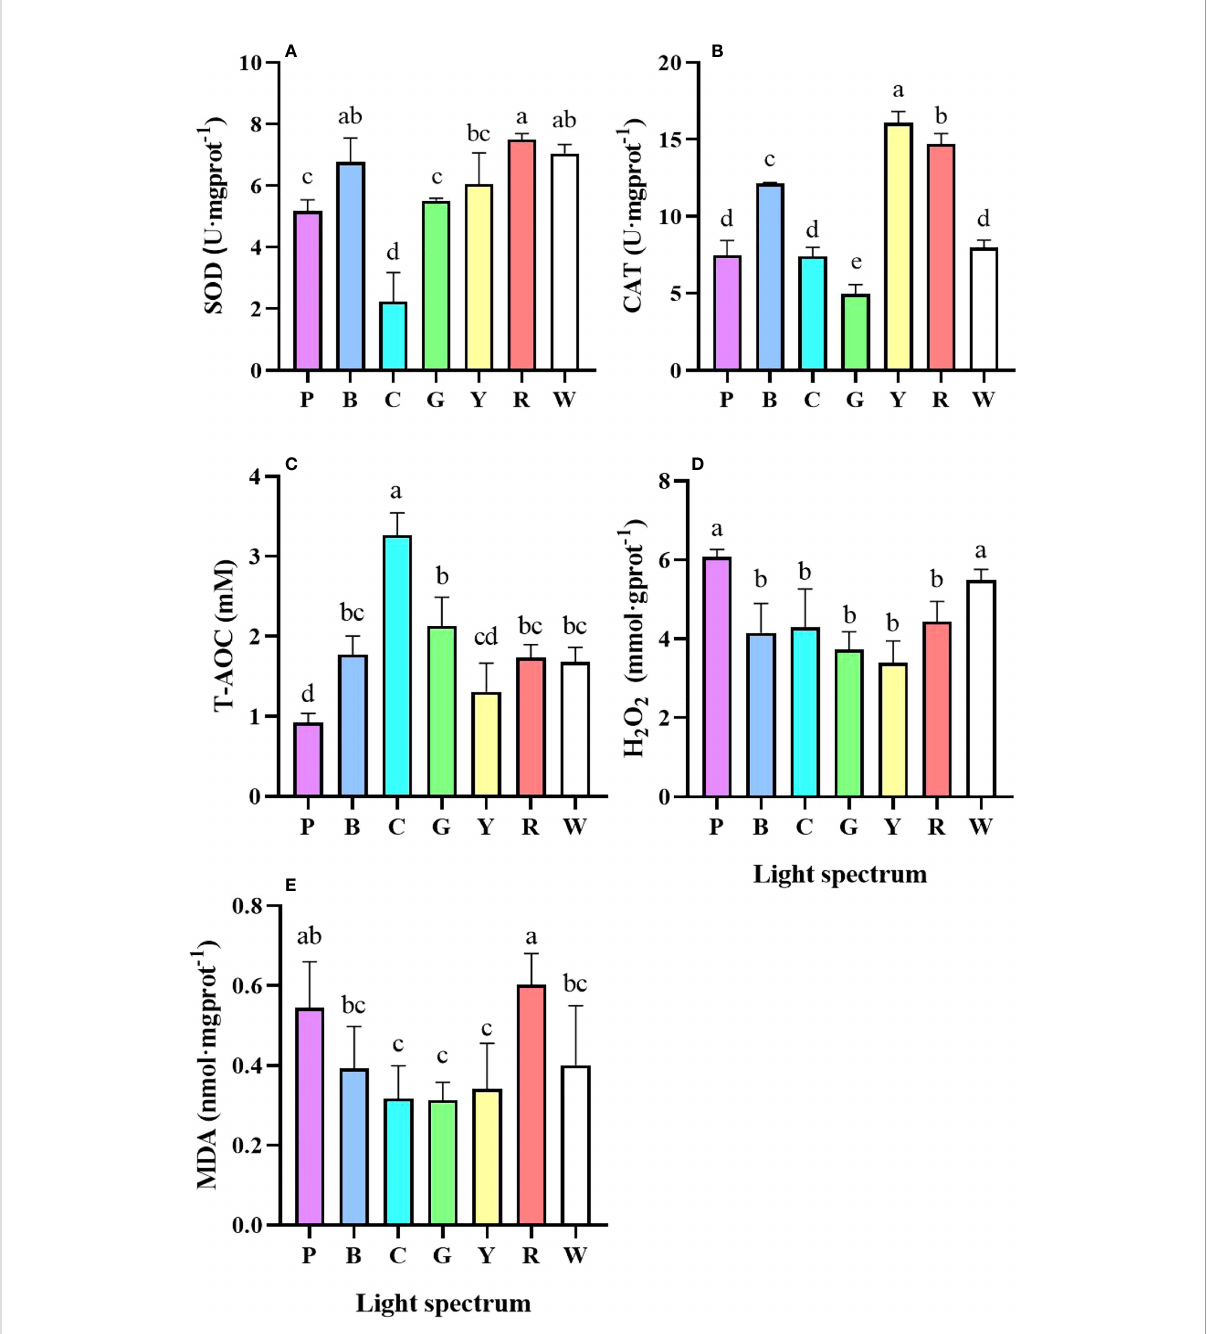
FIGURE 4 The effect of light spectrum on the antioxidant capacity of P. trituberculatus larvae (n = 6). (A) SOD, (B) CAT, (C) T-AOC, (D) H 2 O 2 , (E) MDA. P, Purple; B, Blue; C, Cyan; G, Green; Y, Yellow; R, Red; W, White. Different letters indicate signi fi cant differences ( P